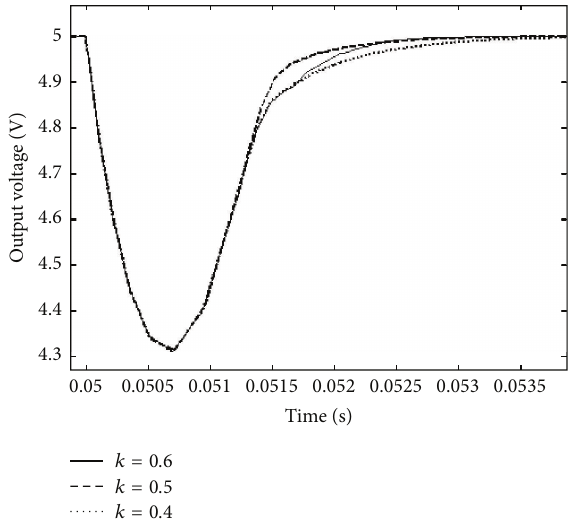
Figure 12: The DC/DC output voltage variation about step load variation time.